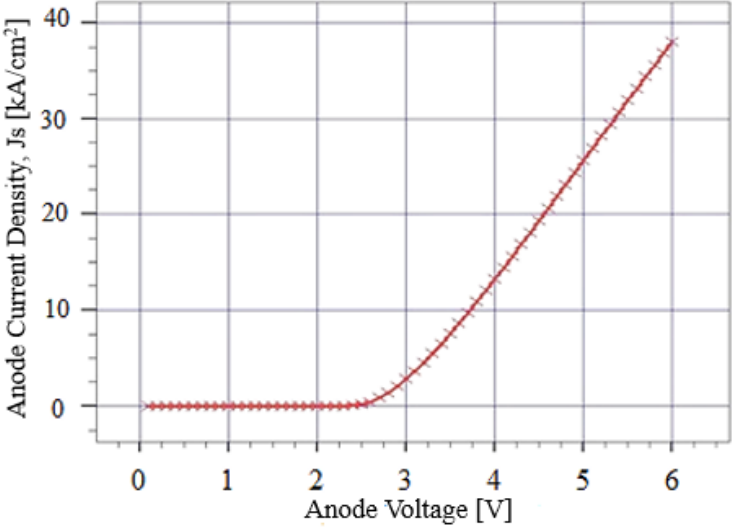
Figure 6. Anode voltage vs. anode current density of simulated SiC LED.